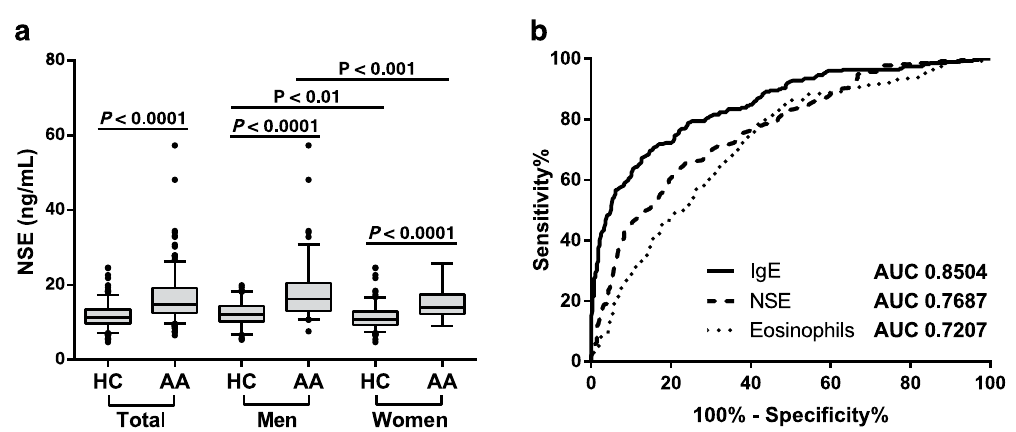
Figure 1. Analysis of NSE values in serum from AA and HC. ( a ) NSE levels in allergic asthmatics (AA) and healthy controls (HC) segregated by gender. Numbers on the graphs represent P -values (Mann-Whitney U test). ( b ) ROC curves for IgE, NSE and peripheral blood eosinophils. AUC values are shown for each